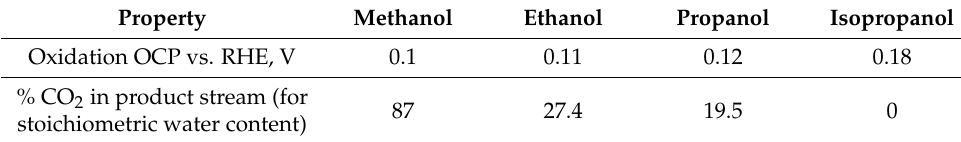
Table 2. Comparison of the properties of simple alcohols. Property Methanol Ethanol Propanol Isopropanol Oxidation OCP vs. RHE, V 0.1 0.11 0.12 0.18 % CO 2 in product stream (for stoichiometric water content)